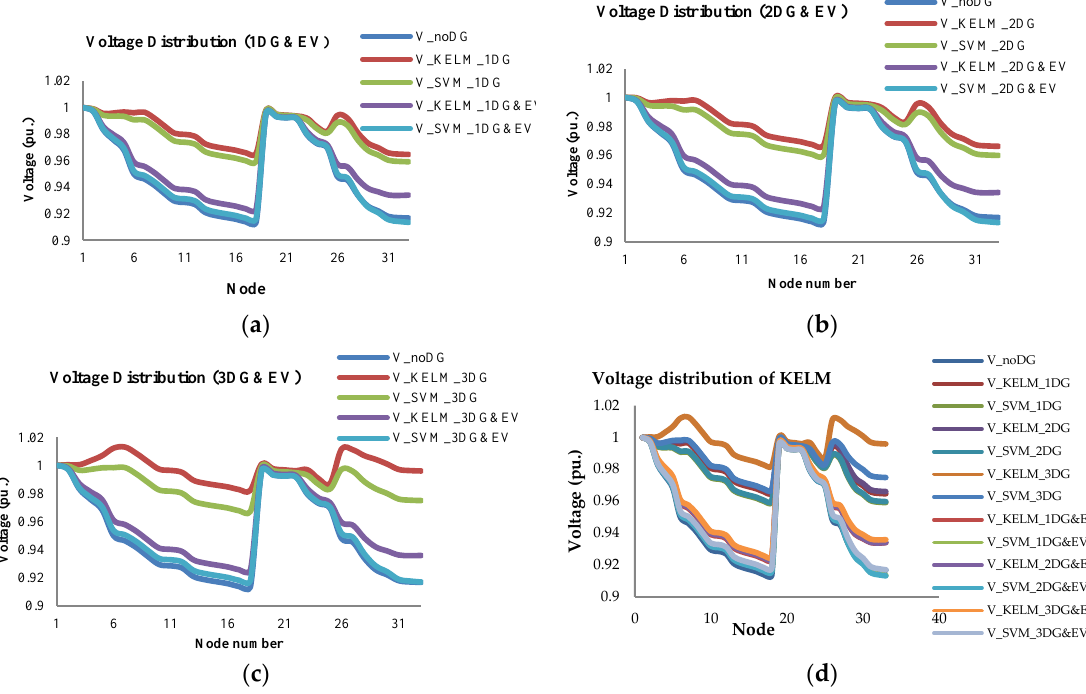
Figure 7. Voltage distribution curves by comparing KELM with SVM under different DG&EV configuration scheme; ( a ) DG access in case1 and with or without EV; ( b ) DG access in case2 and with or without EV; ( c ) DG access in case3 and with or without EV; ( d ) voltage profile of KELM with different DG access modes and with or without EV.(DG: Distributed generation; EV: Electric vehicle)